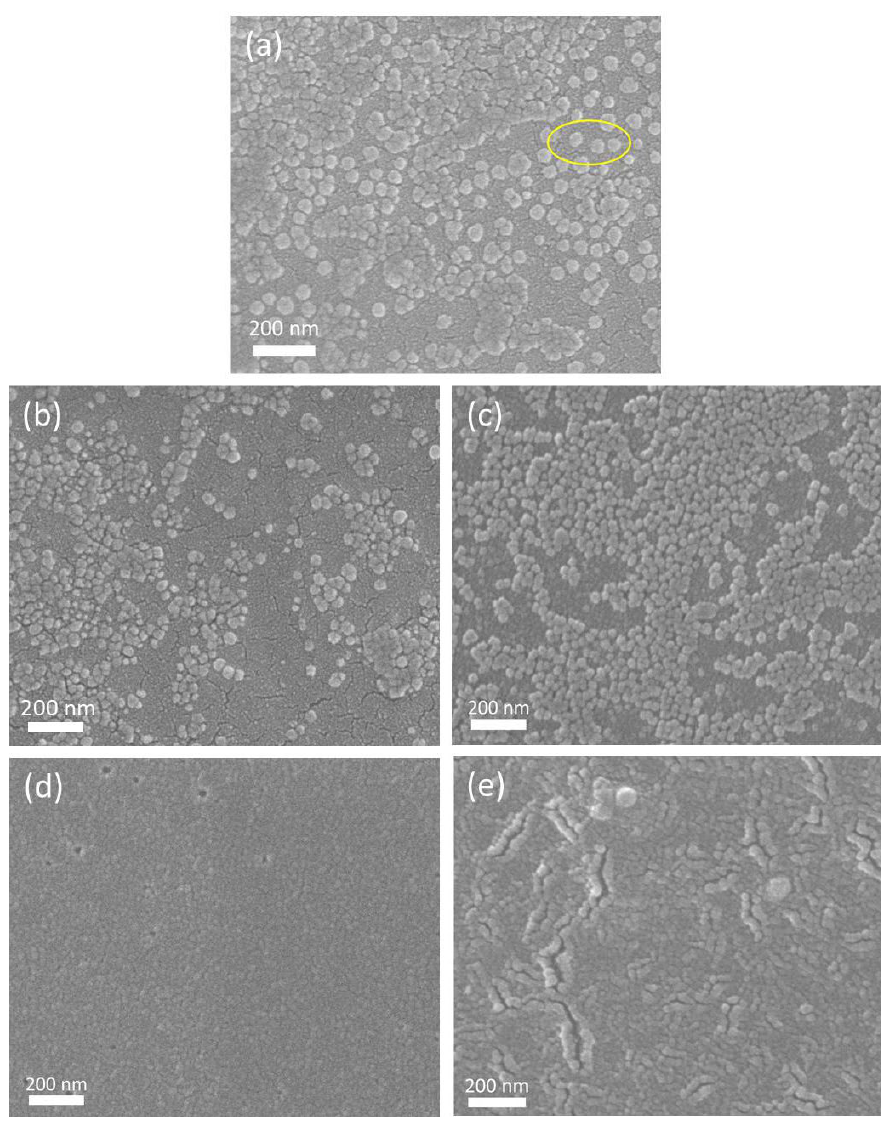
Figure 2. SEM images of PIS10 ( a ), PIS10-560-1 ( b ), PIS10-560-3 ( c ), PIS10-560-6 ( d ), PIS10-560-10 ( e ). The optical transmittance spectra of PI/SiO 2 films are displayed in Figure 3. The transmittance of the PI film (obtained from TFDB-6FDA) at about 400 nm is higher than 85%, and the average transmittance in the visible range can reach up to 91.4%. However, the traditional PI film (obtained from ODA-PDMA) has a transmittance of almost zero at about 400 nm, and the average transmittance in the optical range can only arrive at 65% [21–23]. After using the in situ polymerization method to incorporate 10 wt% SiO 2 na- noparticles into the PI matrix (TFDB-6FDA system), the transmittance of all films in the 350–800 nm wavelength range significantly decreases. When the addition of KH-560 is 1%, the transmittance of PIS10-560-1 film is slightly higher than that of PIS10 in the wavelength range of about 370–800 nm. The transmittance spectrum of PIS10-560-3 in- tersects with PIS10 at 475 nm. At this point, the transmittance of the former on the left is lower than that of the latter, and on the right, it is higher than that of the latter. Fur- thermore, to increase the additive amount of coupling agent, the transmittance of PIS10-560-6 and PIS10-560-10 films decreased significantly. In addition, with the addition